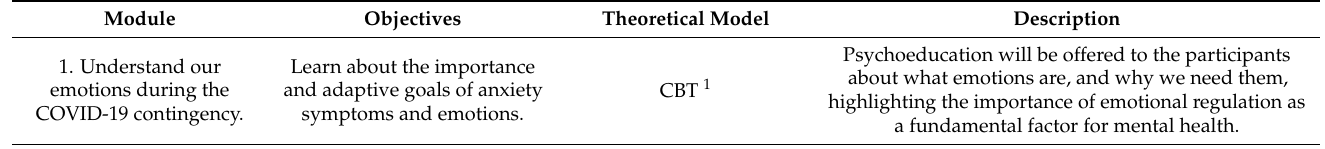
Table 2. Contents of the intervention